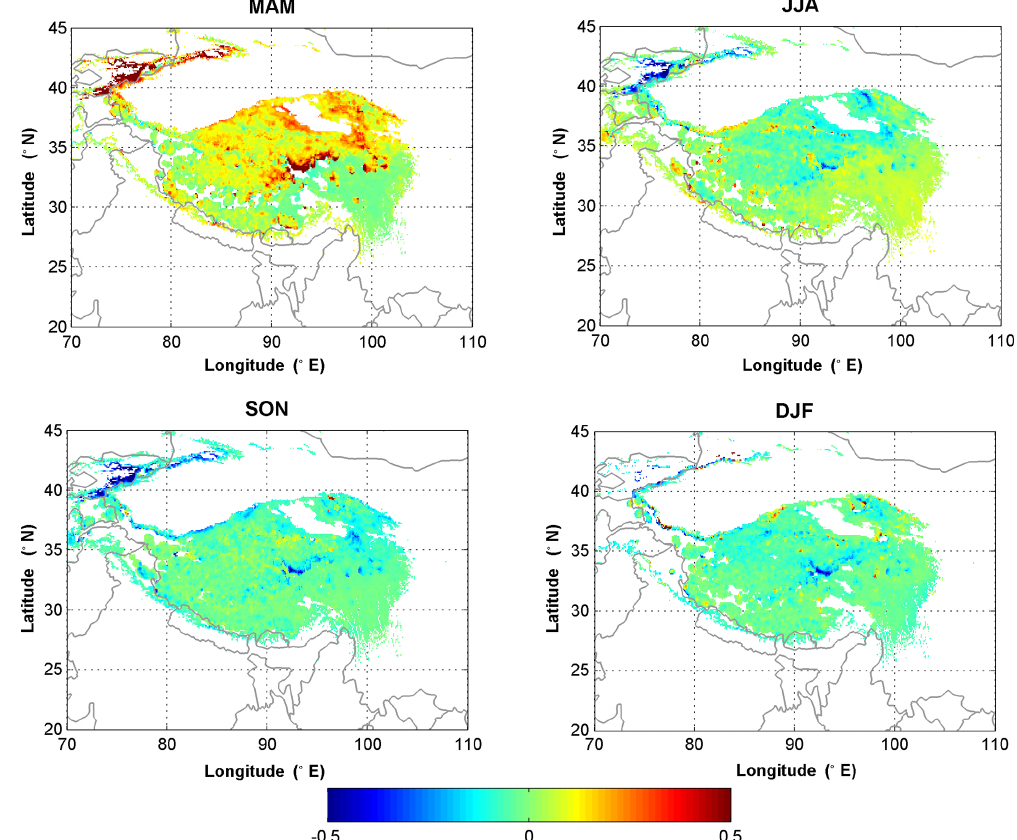
Figure 7. The seasonal departure of MODIS_AOD over the Tibetan Plateau (altitude > 3000m). Table 3. The percentages of EAE < 0.5, 0.5–1.0, and > 1 . 0 for high AOD observations at the five